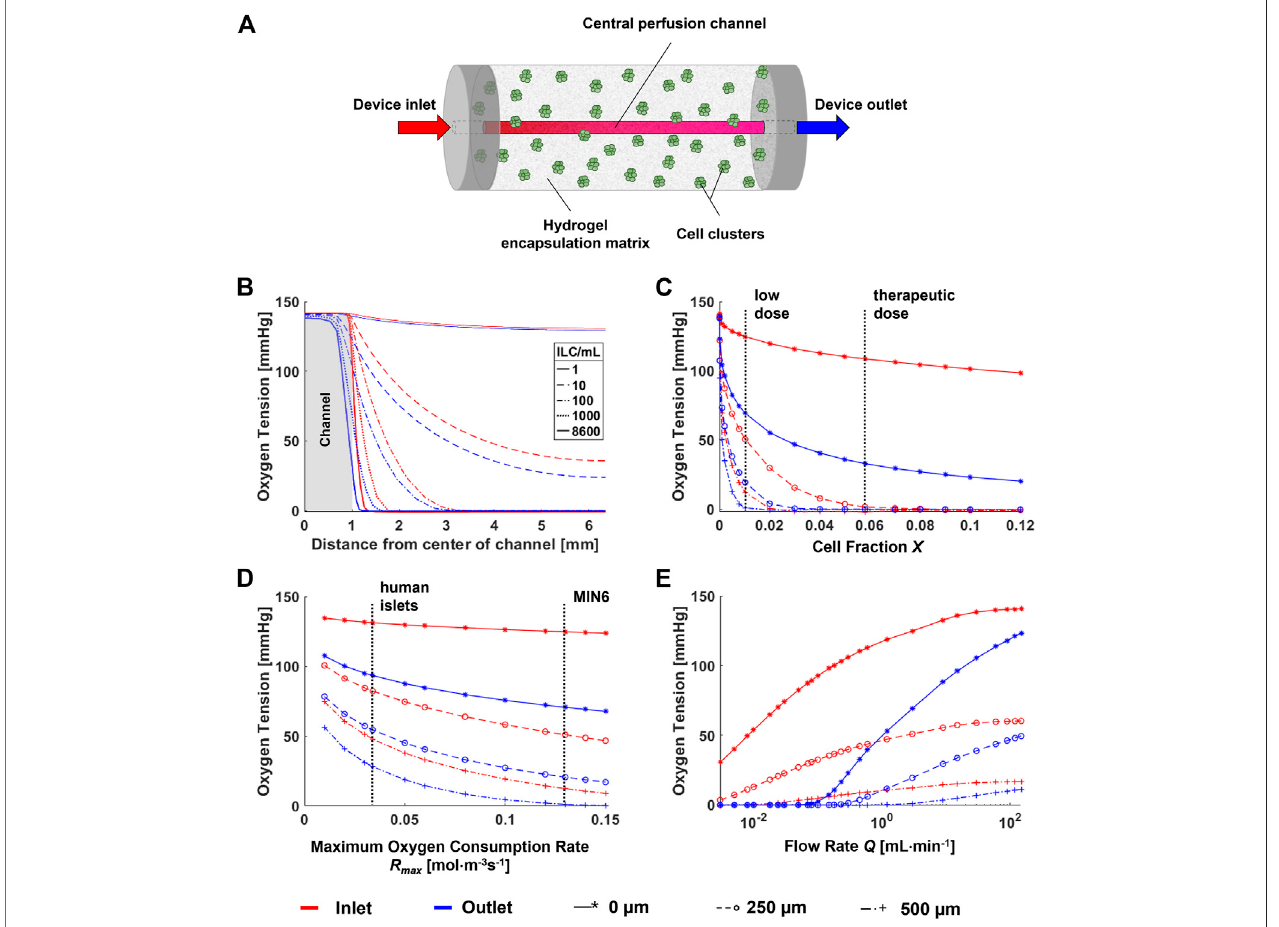
FIGURE 3 | Parametric analysis for a computational model of a single-channel macroencapsulation device. (A) Schematic of the major device components. Cell clustersare immobilized inahydrogel encapsulationmatrixfeaturingacentralperfusion channel. (B) Radial oxygen pro fi les at varyingcell densitieswithin thedevice. (C) Sensitivity of the model to cell fraction X . Vertical lines indicate “ low ” (1,000 ILCs/mL) and “ therapeutic ” (8,600 ILCs/mL) doses of MIN6 islet-like clusters (ILCs). The therapeutic dose is calculated by scaling a therapeutic dose of human islets to an equivalent number of MIN6 ILCs based on oxygen consumption rate (OCR). (D) Sensitivity of the model to the maximum oxygen consumption rate R max . Vertical lines indicate the oxygen consumption rate of MIN6 ILCs (obtained experimentally) and humanislets(fromliterature)(Papasetal.,2007a). (E) Effectof fl owrateontheconcentrationpro fi le.Thecolourlegendforallpanelsanddatalegendforpanels (C – E) are located at the bottom of the fi